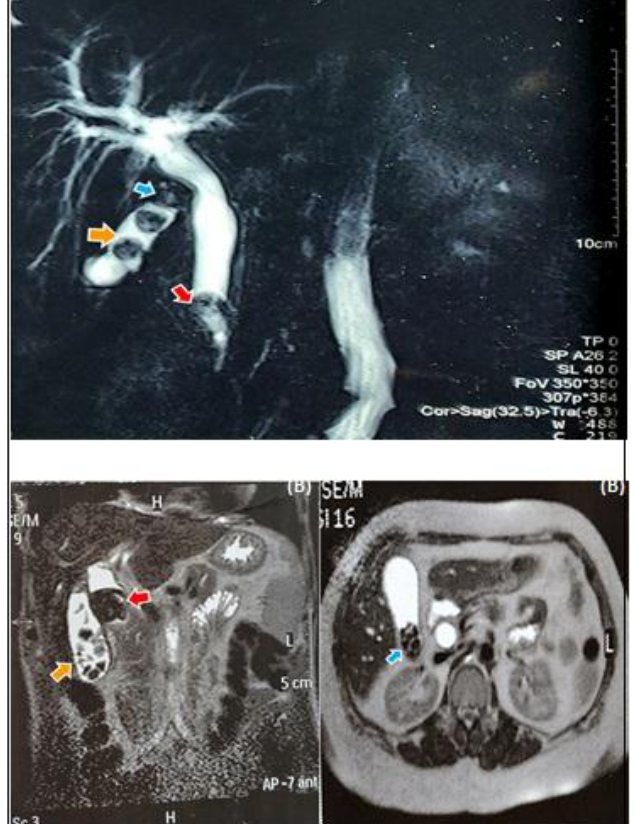
Figure 3: (A) MRCP image of stones in chronic scleroatrophic gallbladder with impaction inside the Hartmann’s pouch complicated with secondary distal impacted CBD stones and stricture. (B) MRCP images of secondary giant CBD stone combined with impacted multiple